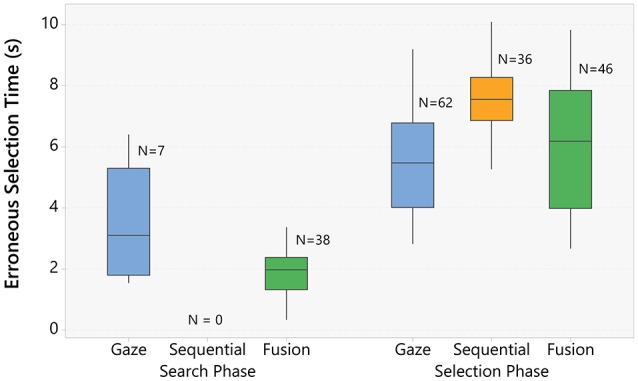
Boxplot of the mean error selection time grouped by selection technique and whether the selected target was a neighbor or not of the real target. The number of errors, and the individual values for each error are also provided in the plot.